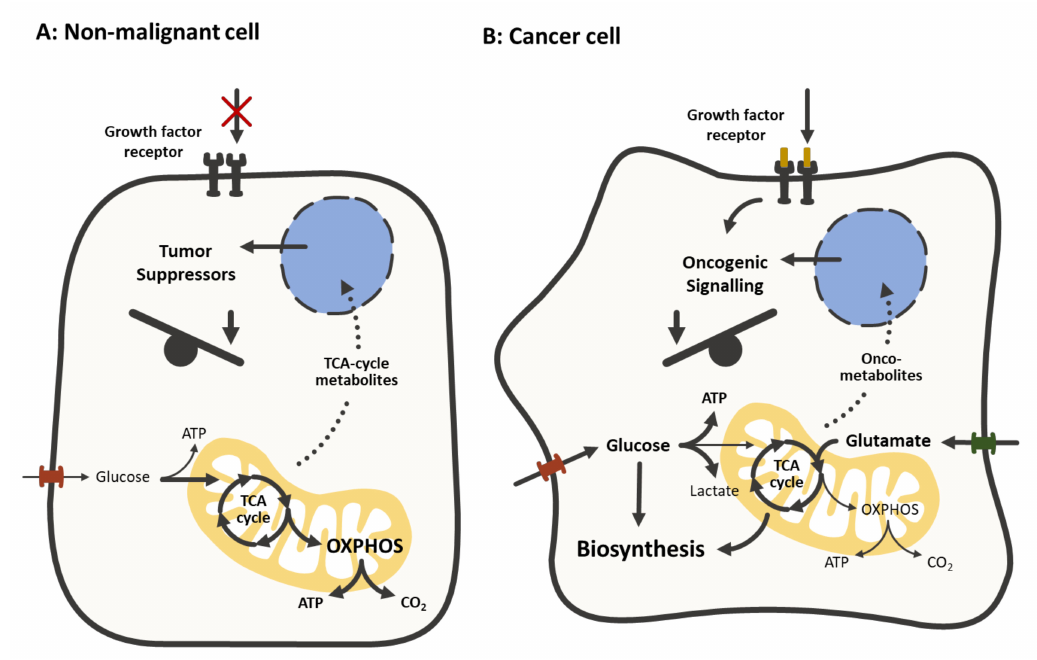
Figure 1. Comparison of the metabolism in non-malignant cells ( A ) and cancer cells ( B ) In most non-malignant cells, the absence of growth factor signaling, the limited supply of nutrients and the activity of tumor suppressors promotes oxidative phosphorylation (OXPHOS) in order to maximize the energetic yield. In cancer cells, growth factor signaling and oncogenes facilitate the transporter-mediated uptake of nutrients (e.g., glucose, glutamate) to supply a metabolic shift towards the biosynthesis of lipids, nucleotides and proteins. The TCA cycle serves as the main hub, connecting anabolic and catabolic processes by generating and providing intermediates. Metabolites and oncometabolites of the TCA cycle act as signaling